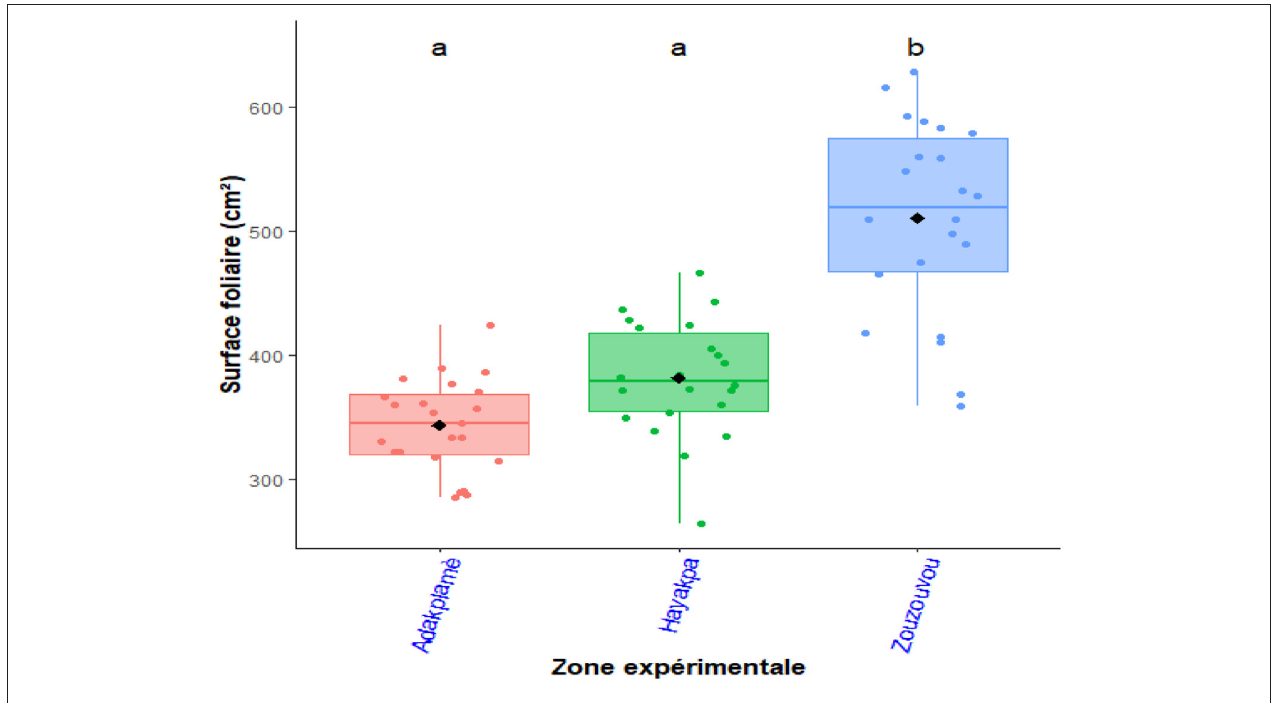
FIGURE 7 | Leaf area of maize plants according to zones.